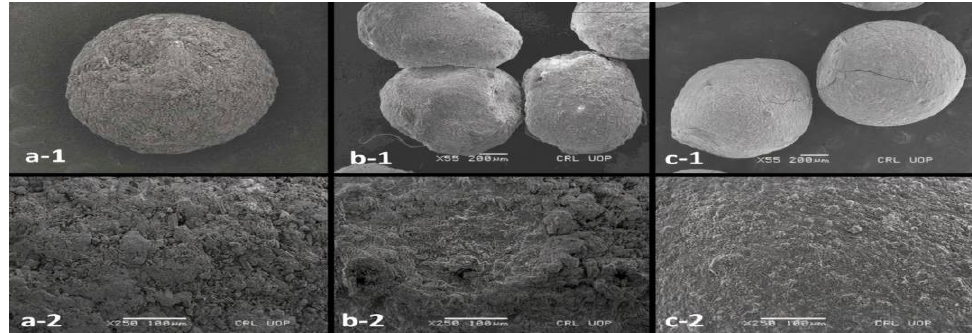
Figure 10. Scanning electron microphotograph showing: ( 1 ) shape; ( 2 ) surface morphology; ( a ) alginate microspheres; ( b ) blended microspheres;( c ) coated microsphere